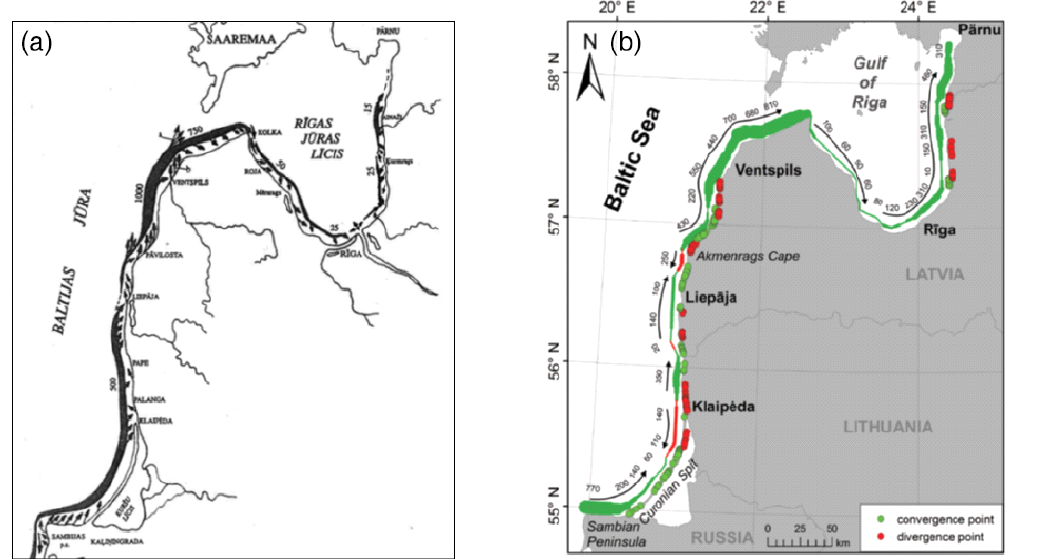
Figure 9. Direction (arrows) and magnitude (numbers at arrows, in 1000m 3 ) of net sediment transport: (a) original scheme by Rudolfs Knaps, amended by Ulsts (1998); (b) simulated potential net sediment transport (Viška and Soomere, 2013). Reproduced with permission from the authors and